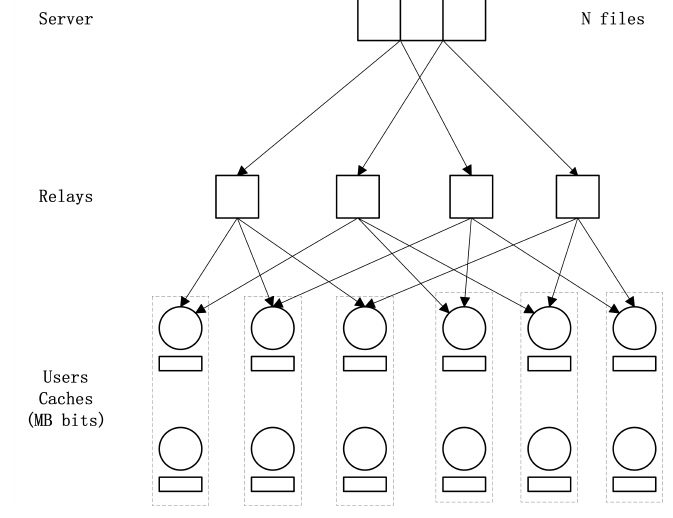
Figure 1. A multiaccess combination network with H = 4, r = 2, u = 2. An F -division ( H , r , u , M , N ) multiaccess combination network caching scheme con- tains the two following